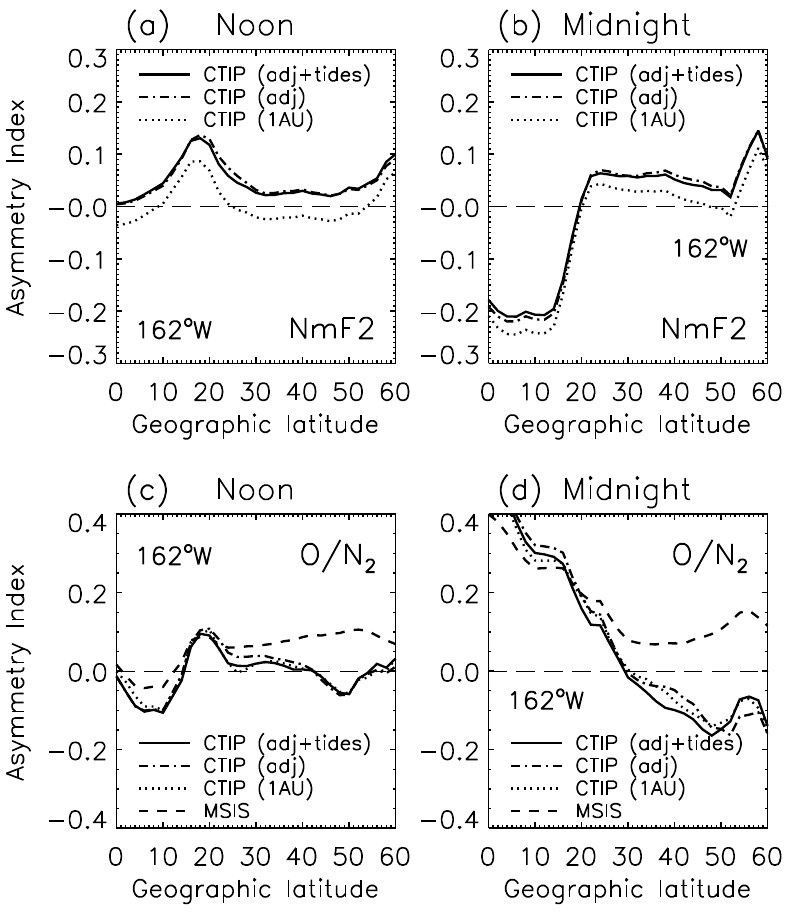
Fig. 5. Latitude variations at longitude162 ◦ W Above: Asymmetry index of Nm F2 at noon and midnight. Dotted curves, CTIP, no meso- spheric tides, Sun-Earth distance fixed at 1AU. Solid curves: CTIP including mesospheric tides, adjusted for Sun-Earth distance. Below: Asymmetry index of neutral O/N 2 ratio at noon and midnight. Dotted curves, CTIP, no mesospheric tides, with Sun-Earth distance fixed at 1AU. Solid curves: CTIP adjusted for Sun-Earth distance, including mesospheric tides. Dashed curves: Mass Spectrometer Incoherent Scatter Model (MSIS). In all CTIP cases, the values for “no tide”, adjusted Sun-Earth distance’ (not shown) are about 0.03 higher than the 1AU